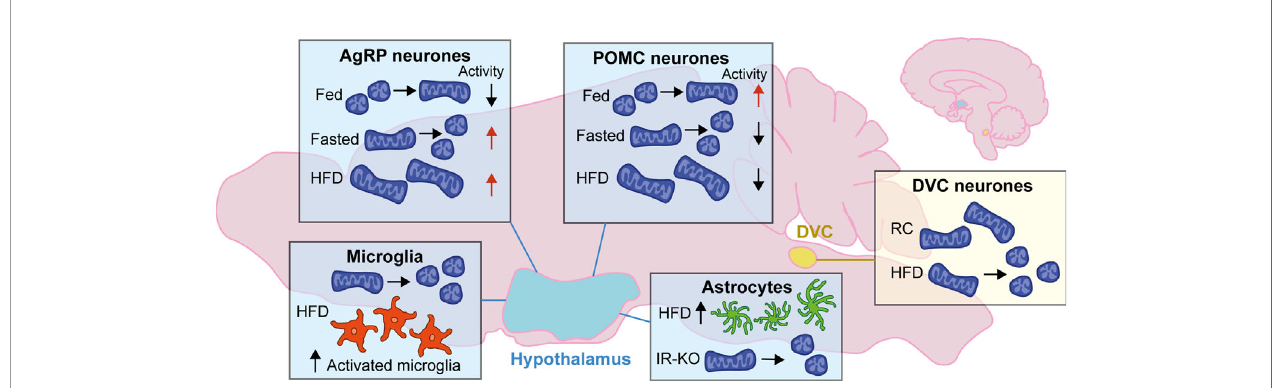
FIGURE 1 | Changes to mitochondrial dynamics in response to diet in the hypothalamus and DVC: Mitochondrial dynamics in the brain change depending on energy status. In the hypothalamus, neurons favor mitochondrial fusion following feeding and fi ssion when fasted. The activity of AgRP and POMC neurons are antagonistic; following feeding AgRP neurons decrease activity while POMC neuron activity is increased while in the fasted state it is the opposite. Following high-fat diet (HFD) mitochondria favor fusion and become enlarged; AgRP neurons are highly active, and POMC neuronal activity is decreased. In microglia of the hypothalamus mitochondria favor fi ssion with HFD, and there is an increase in the number of activated microglia in the ARC. There is also an increase in the number of astrocytes in the hypothalamus with HFD, and knockout of the insulin receptor (IR-KO) in astrocytes led to favoring mitochondrial fi ssion. In the DVC, HFD leads to mitochondrial fi ssion when compared to regular chow (RC) fed